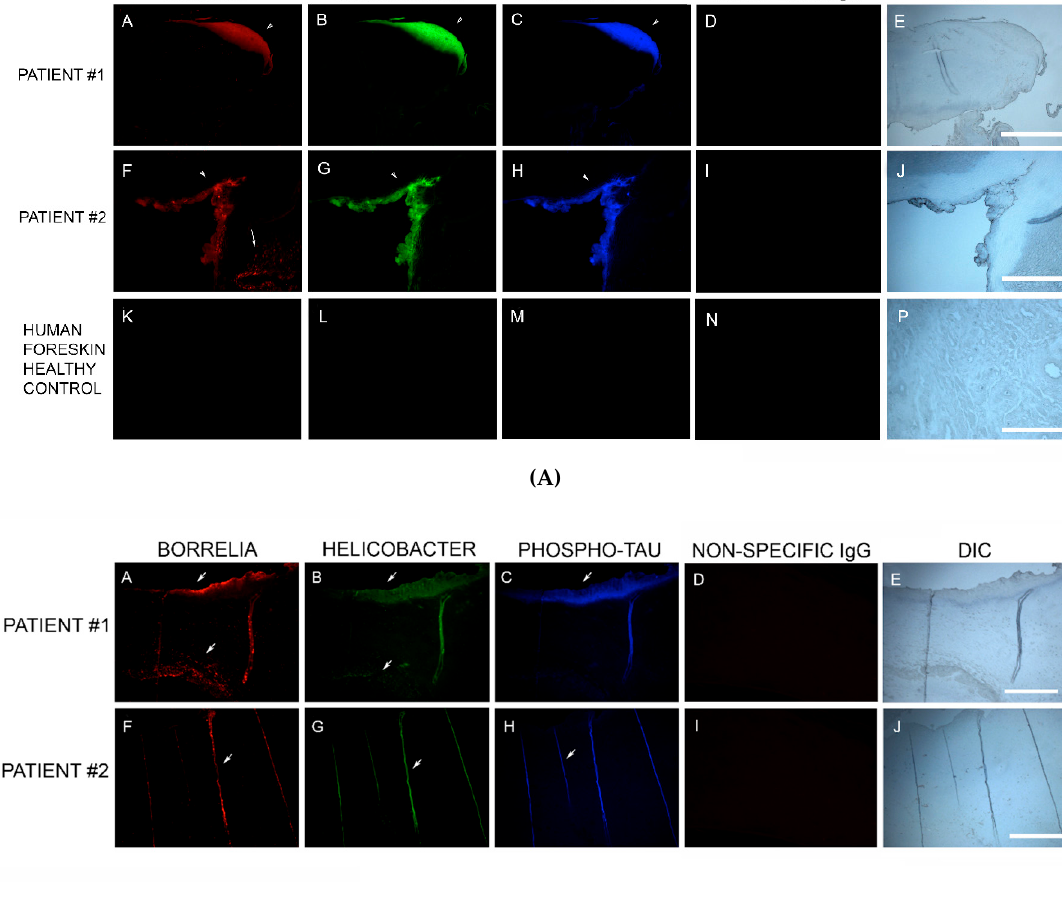
Figure 7. ( A ) Representative IHC images of phospho-tau reactivity co-localizing with Borrelia and Helicobacter in aggregate biofilm structures of MD skin sections from two subjects (A–D and E–H). IHC detection was performed as described in the Methods section. Panels A and E demonstrate positive reactivity with anti-Borrelia burgdorferi antibody (red). Panels B and F demonstrate positive reactivity with anti-Helicobacter antibody (green). Panels C and G demonstrate positive reactivity with anti-phospho-tau antibody (blue). Panels I, J and K demonstrate lack of reactivity with non-specific antibody. Panels D, H and L show sections imaged with DIC. ( B ) Representative IHC images of phospho-tau reactivity co-localizing with Borrelia and Helicobacter in fibers of MD skin sections from two subjects (A–D and E–H). IHC detection was performed as described in the Methods section. Panels A and E show reactivity with anti-Borrelia antibody (red). Panels B and F show reactivity with anti-Helicobacter antibody (green). Panels C and G show reactivity with anti-phospho-tau antibody (blue). Panels D and H show sections imaged with DIC. All images were taken at 200× magnification.